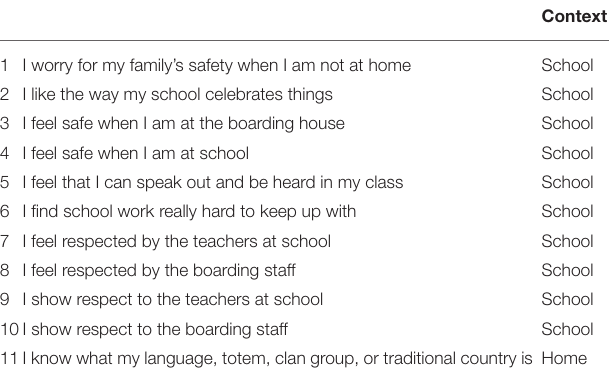
TABLE 1 | Site specific questions for Australian Indigenous boarding